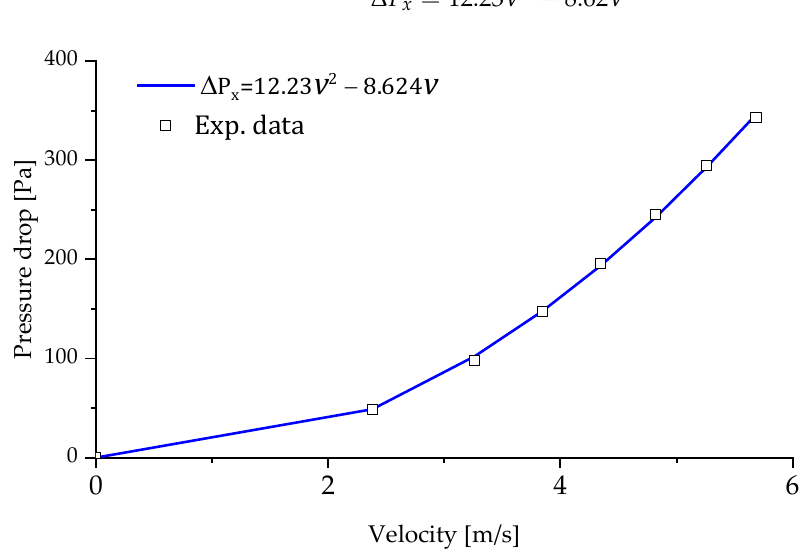
Figure 5. Relationship between pressure drops and velocity in the flame arrestor.